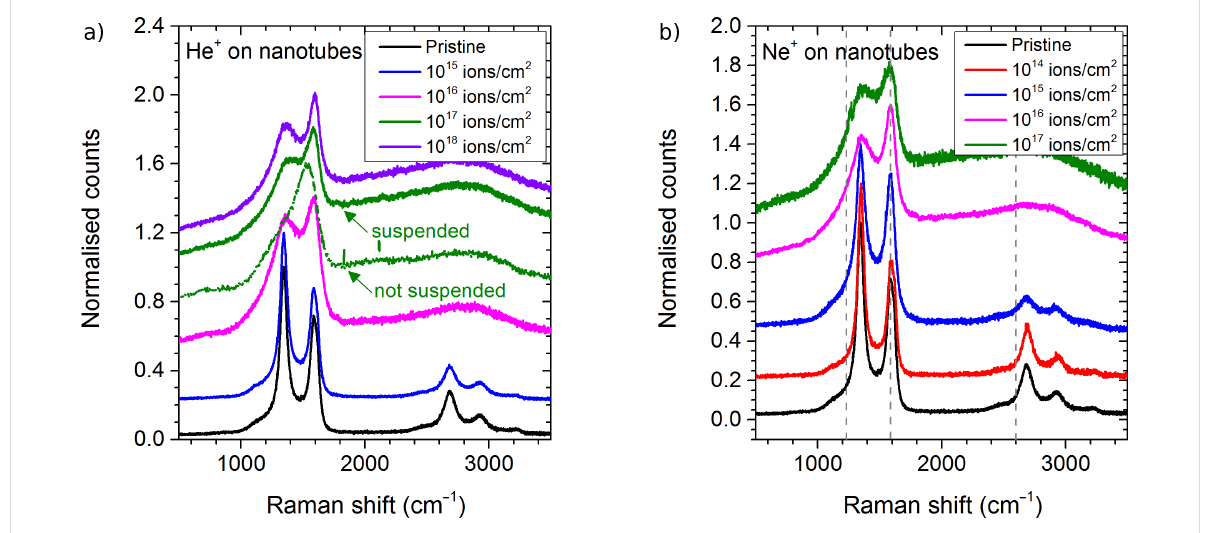
Figure 1: Raman spectra of multiwalled carbon nanotubes after irradiation with different fluences of a) 25 keV He + , and b) 25 keV Ne + ions. A laser with a wavelength of 532 nm was used. All the spectra (except the one pointed out) were obtained on suspended free-standing